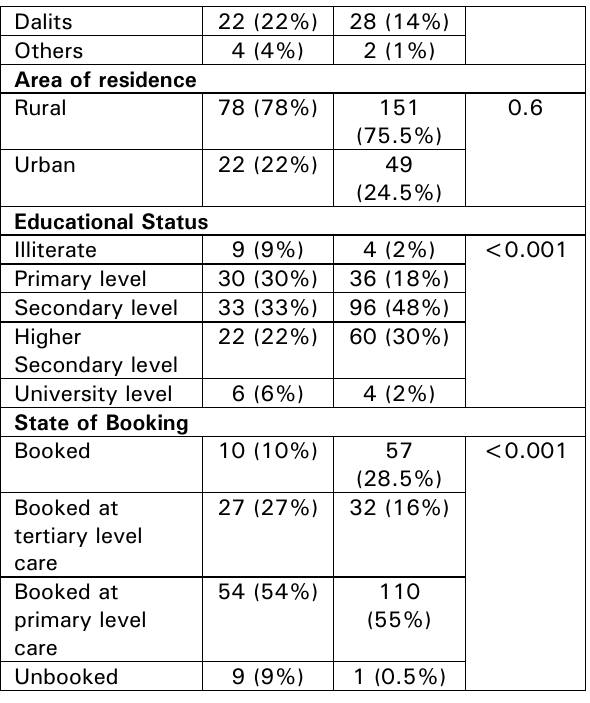
Figures in the parentheses indicated percentage